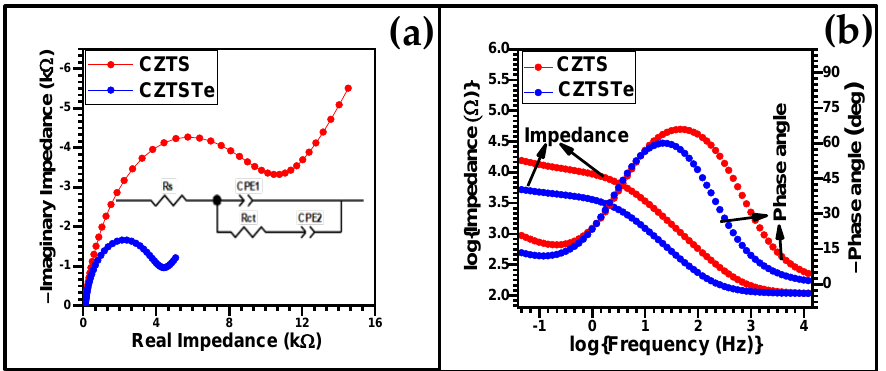
Figure 9. Electrochemical impedance spectroscopy (EIS) data: ( a ) Nyquist and ( b ) Bode plots for CZTS and CZTSTe nanomaterials. (0.1 M lithium perchlorate in acetonitrile was used as the supporting electrolyte). Table 2. EIS parameters of CZTS and CZTSTe nanomaterials.